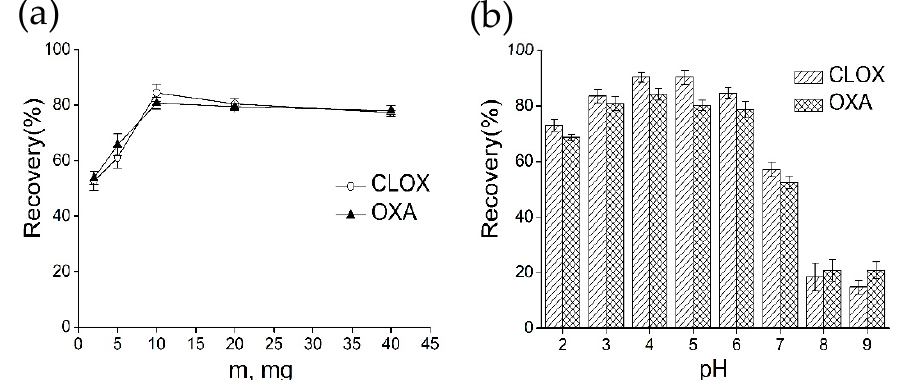
Figure 6. Effect of the amount of PPy-PA6-NFsM ( a ) and pH ( b ) on the recoveries of analytes. Conditions: sample volume, 20.0 mL; concentration of two analytes, 0.5 μ g/mL; extraction time, 30 min; eluent, 2.0 mL of 1% ammonia/ACN ( v / v ); desorption time, 30 min.